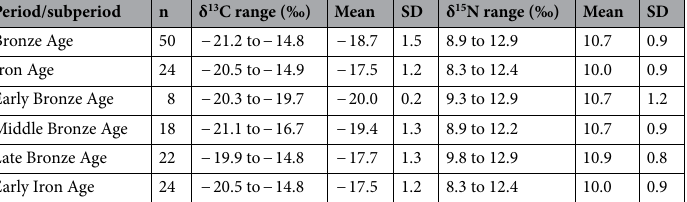
Table 2. Summary of human δ 13 C and δ 15 N results of sample by period and subperiod with ‰ range, mean, and SD (±